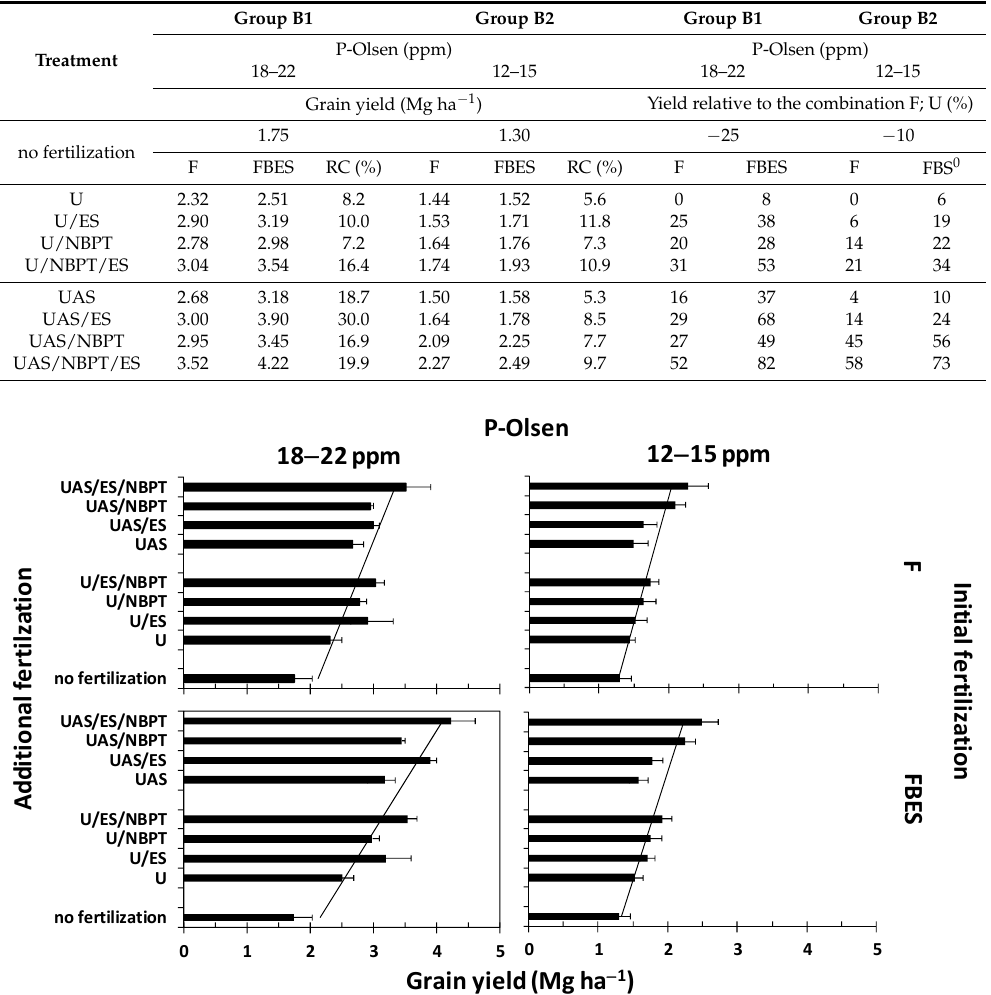
Figure 3. Visualization of the influence of the experiments’ covariates (Phosphorus level, Initial Fertilization and Additional Fertilization) on yield.